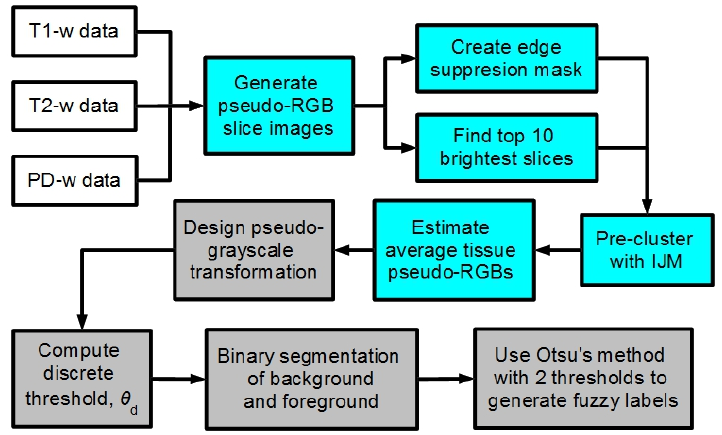
Figure 4. Flowchart of the MS lesion segmentation process. Steps involving the pseudo-RGB images are highlighted in cyan. The subsequent steps using the transformed pseudo-grayscale image are highlighted in light